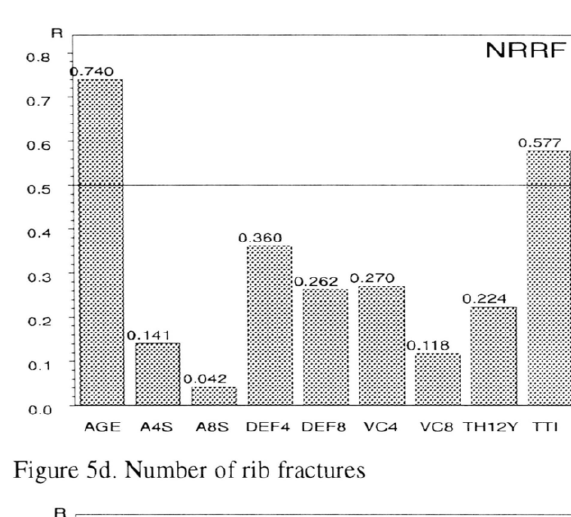
Figure Sa. Thoracic injury severity Figure Sb. Trunk injury severity